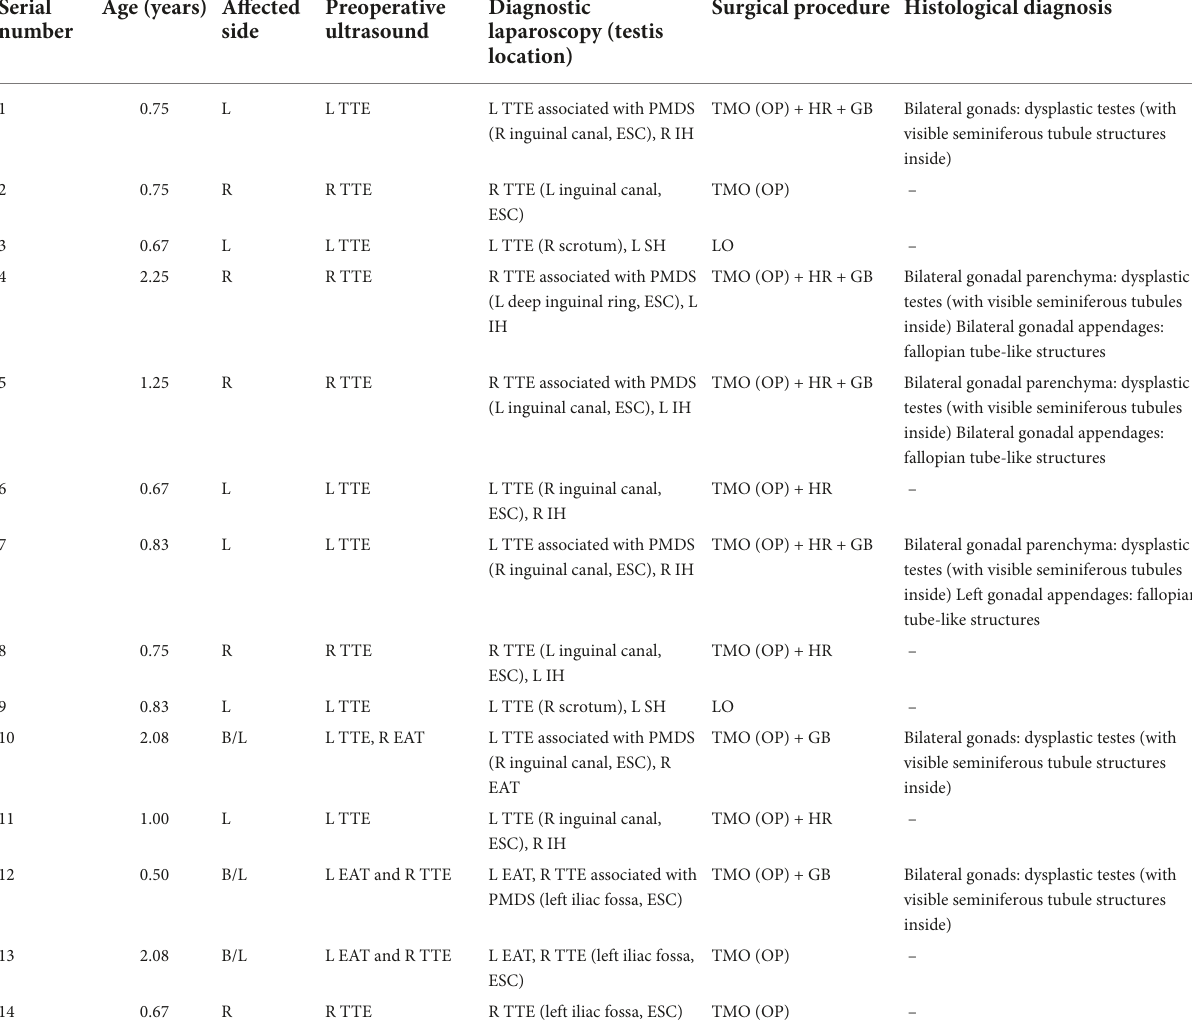
TABLE 3 Age, clinical manifestations, and management of 14 cases of transverse testicular ectopia in children. Serial Age (years) Affected number